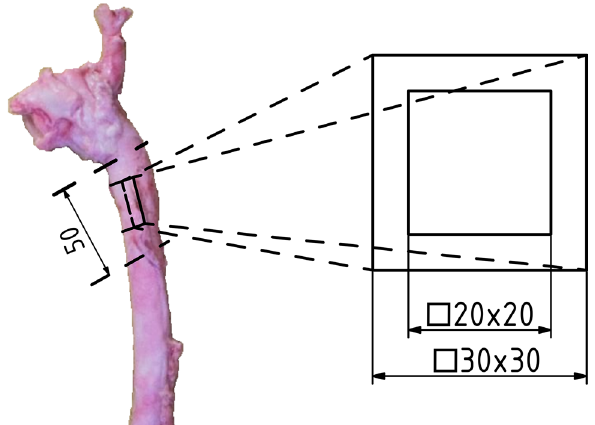
Figure 1. Illustration of place extraction specimen. The 30 × 30 mm large specimen was cut out of each aorta for unloaded thickness estimation. Afterwards 20 × 20 mm sample was cut out of each larger sample for another